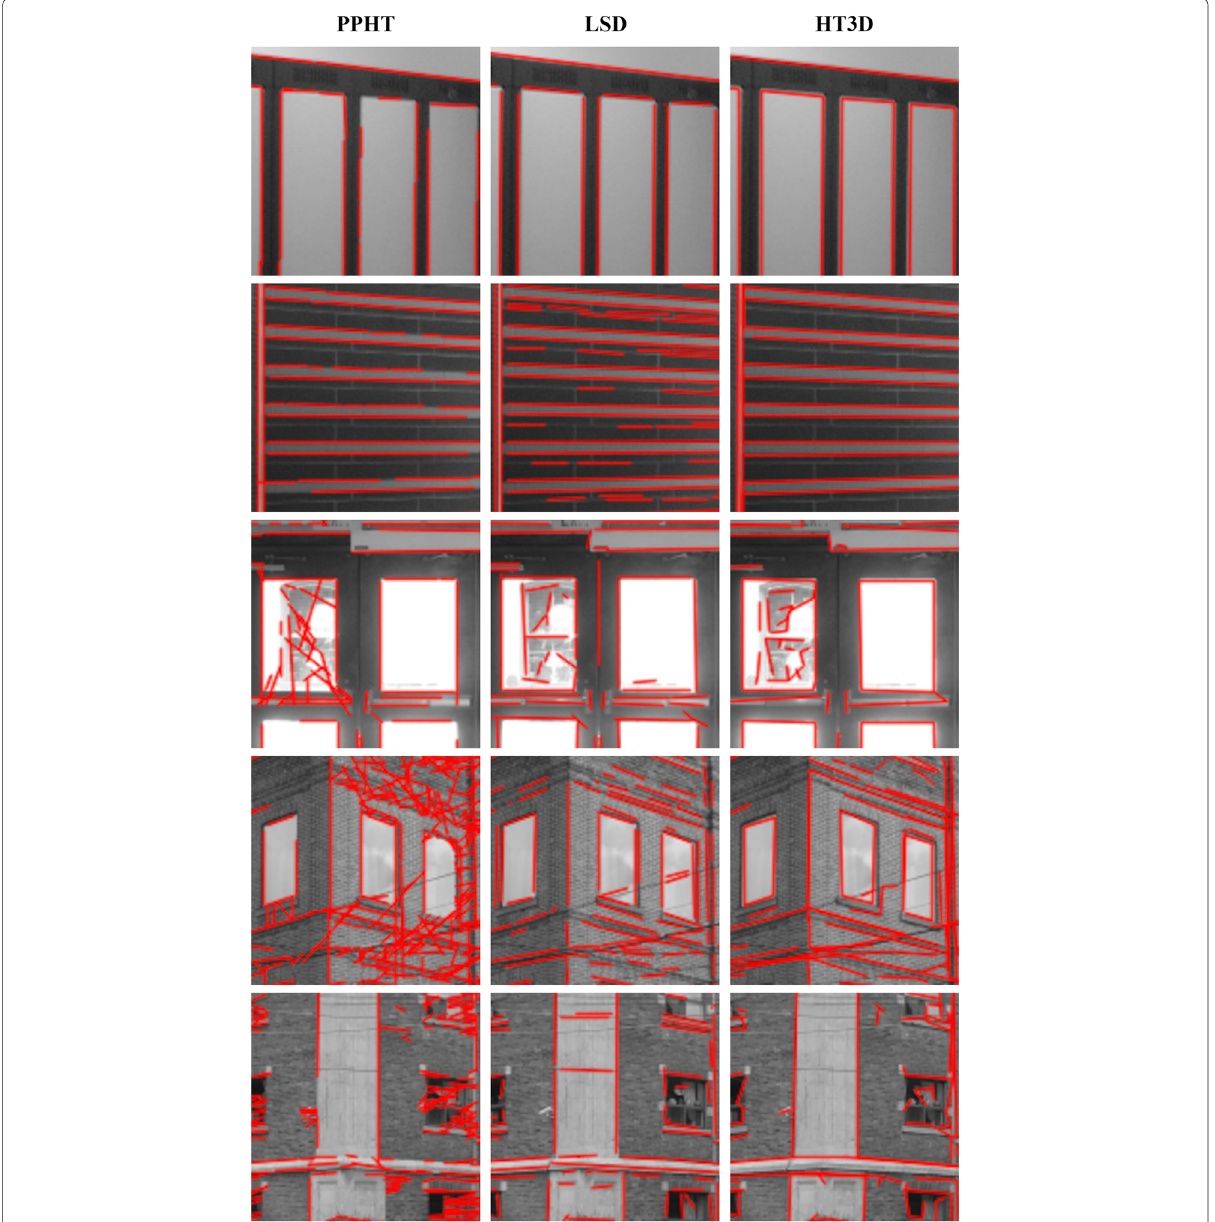
Fig. 22 Zoomed representative regions of the images in Figs. 20 and 21. In this figure, the differences in the line segment detection results of the three methods can be clearly appreciated